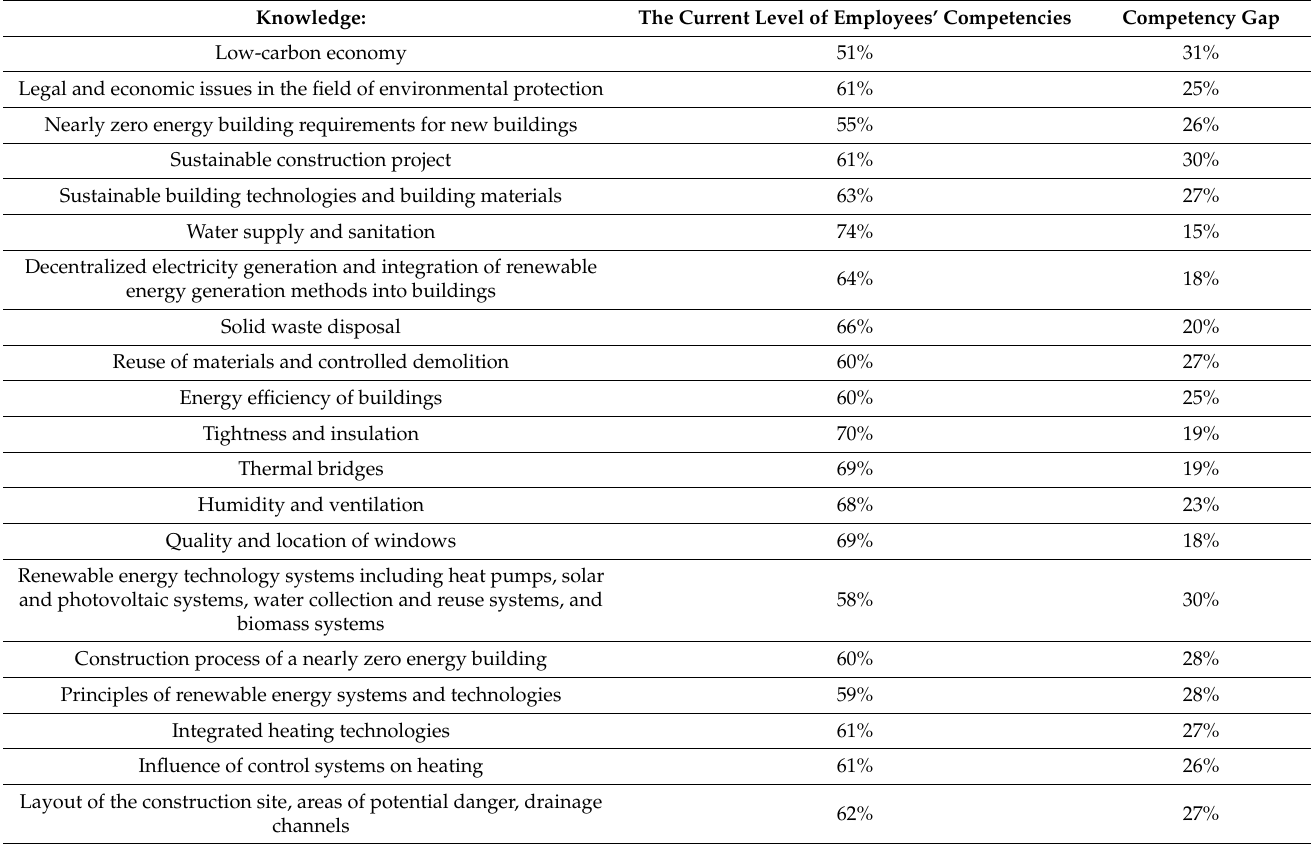
Table 5. Competency gap of employees in the construction industry in the Czech